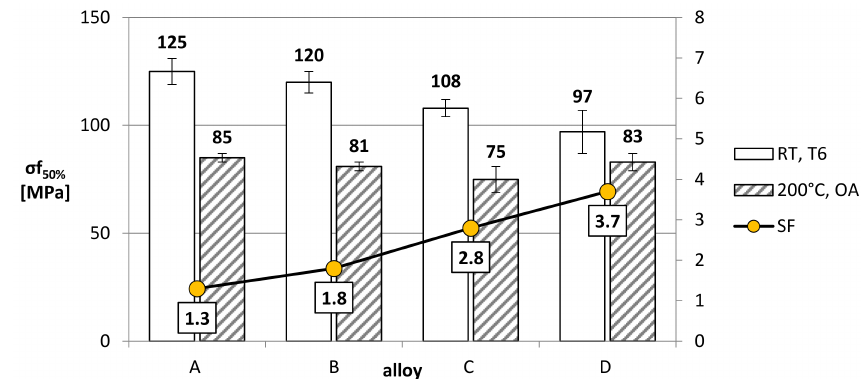
Figure 7. Fatigue strength ( σ f 50% ) and SF of the investigated alloys, tested at room temperature in the T6 condition, and at 200 ◦ C after T6 and overaging (48 h at 200 ◦